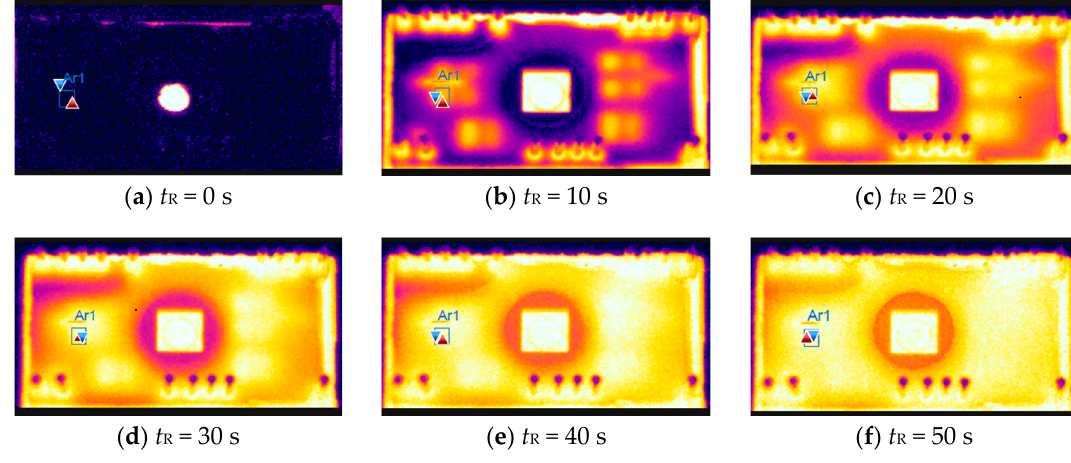
Figure 12. Thermal propagation of the inspected IGBT module with an IR camera.